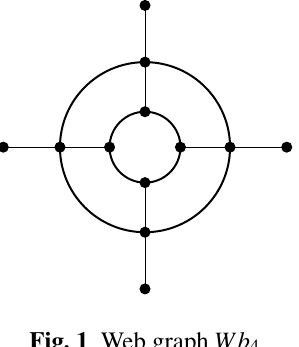
Fig. 1 Web graph Wb